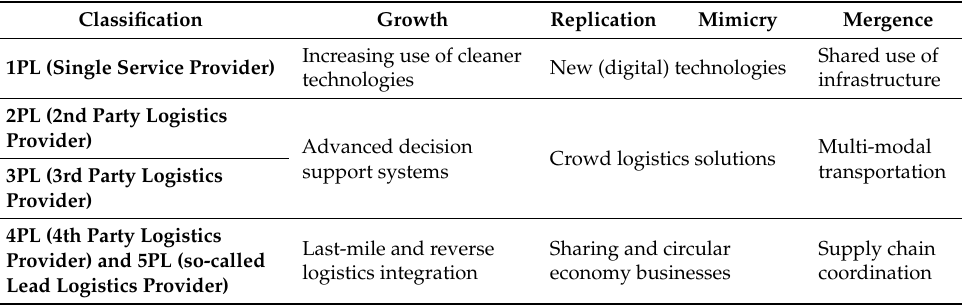
Table 3. Observed sustainable logistical strategies from the expert